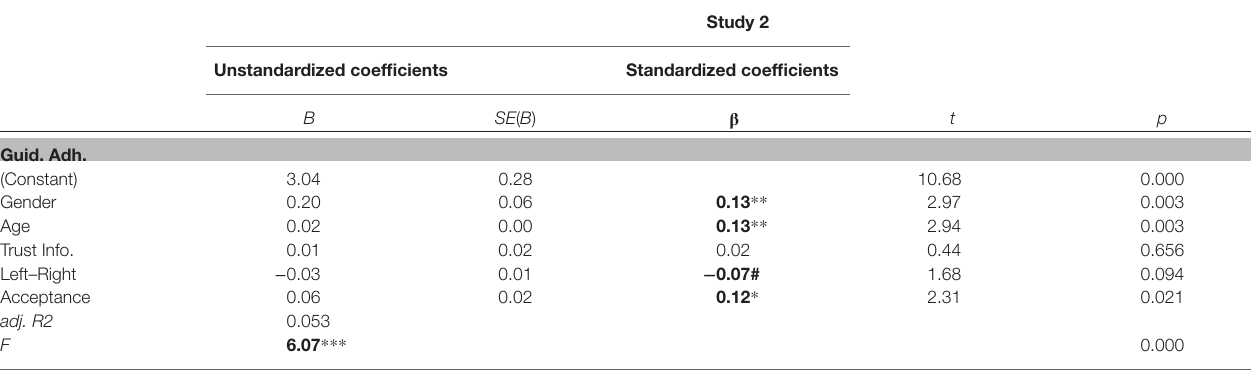
TABLE 7 | Multiple linear regressions on adherence to the social distancing